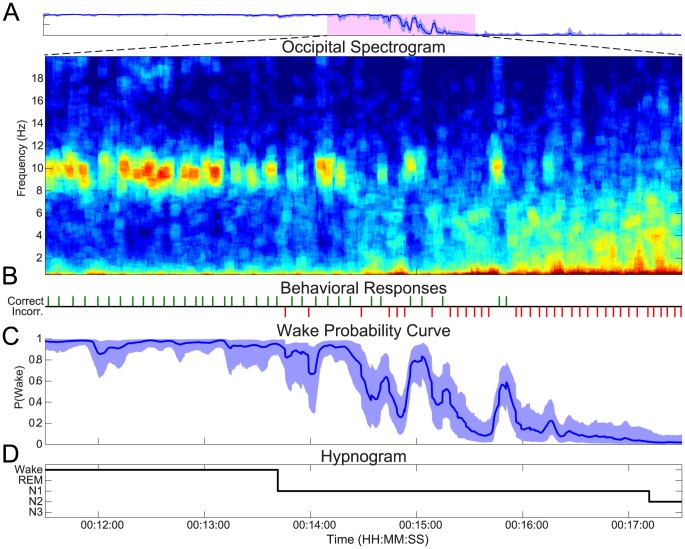
A close up of the sleep/wake transition period of the SOP from the same subject from Figure 3 illustrates the interplay of the EEG and behavior during the SOP.The corresponding (A) spectrogram, (B) behavioral responses, (C) the wake probability curve, (D) and the clinical hypnogram are shown. In (C), the distribution median (curve), and 95% confidence intervals (shaded region) are shown.